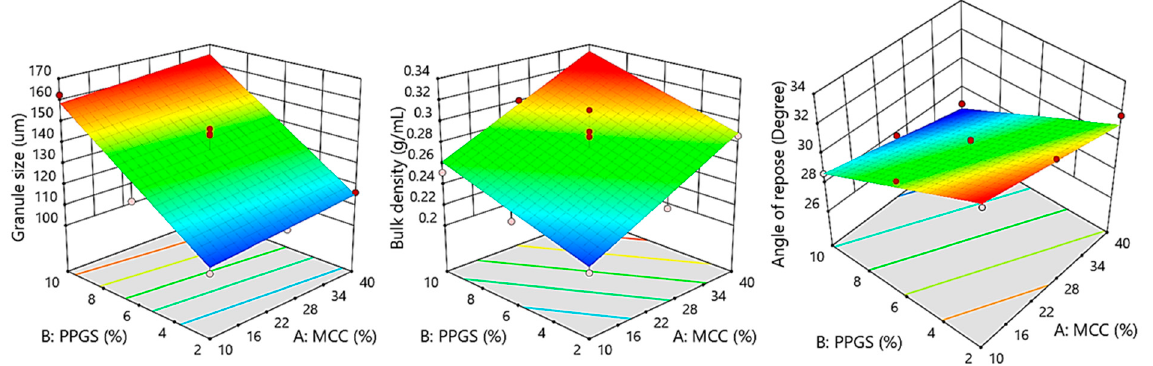
Figure 2. Response surface plots showing the influence of MCC (X 1 ) and PPGS (X 2 ) on measured granules’ responses; mean granule size (y 1 ), bulk density (y 2 ), and angle of repose (y 3 ).